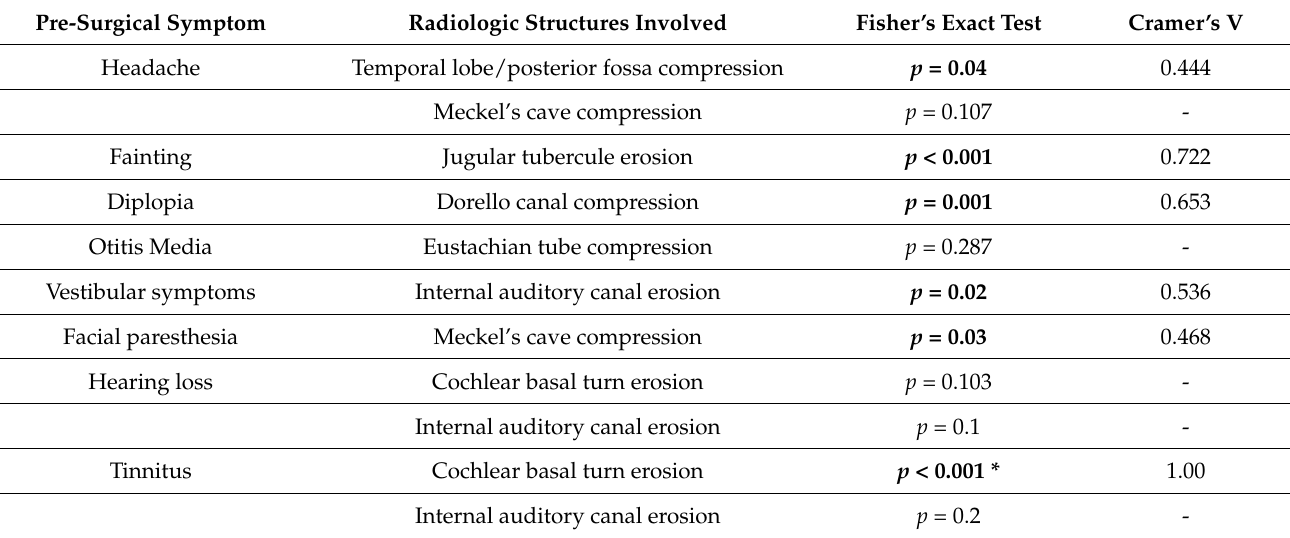
Table 2. Association between referred pre-surgical symptoms and radiologic structures involved with Fisher’s exact test and Cramer’s V index; significant results are shown in